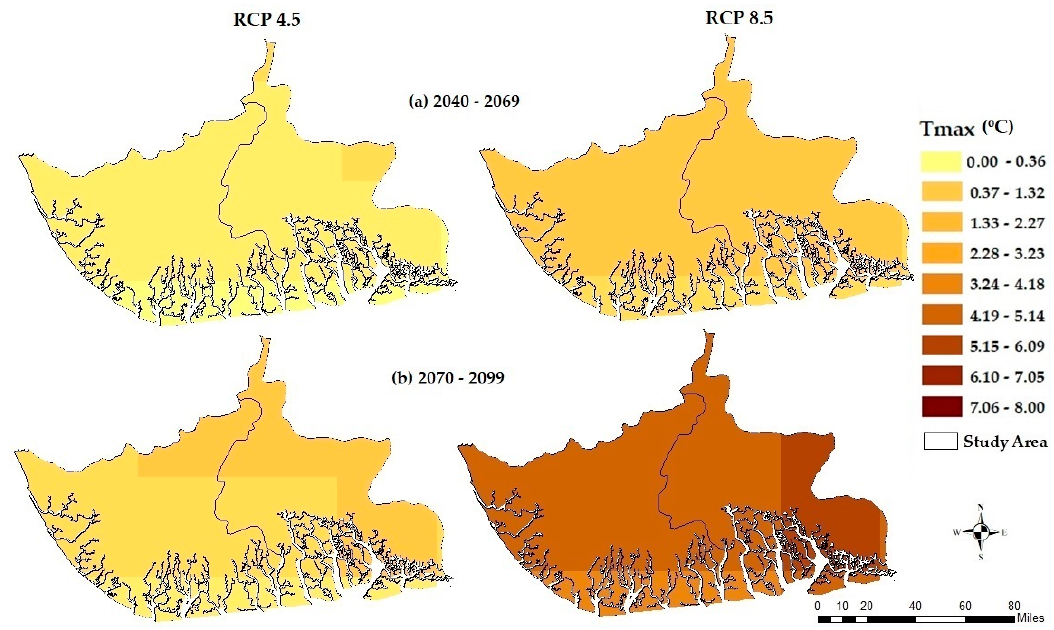
Figure 6. Spatial distribution of percentage changes in average annual prcp, for periods ( a ) 2040–2069 and ( b ) 2070–2099 compared to the base period 1980–2005 for RCP4.5 and RCP8.5.